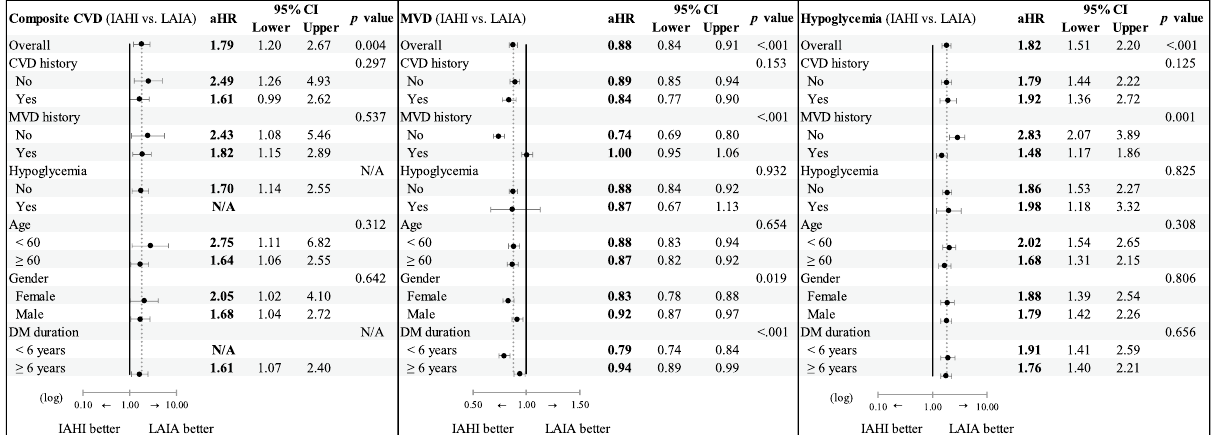
Figure 2. Primary and subgroup analyses for study outcomes of composite cardiovascular diseases, microvascular diseases, and hospitalized hypoglycemia for intermediate-acting human insulin versus long- acting insulin analogue (reference group). IAHI, intermediate-acting human insulin; LAIA, long-acting insulin analogue; aHR, adjusted hazard ratio; CVD, cardiovascular disease; MVD, microvascular disease; DM, diabetes mellitus; N/A, not available. (1) “N/A” indicates “not available”, indicating that the study event number was zero in any comparison subgroup and thus the analysis was not performed. (2) The variables adjusted in these analyses were age, gender, hospital grade, history of retinopathy, and cerebrovascular disease, which are shown to be statistically different between IAHI and LAIA users at baseline (in terms of standardized mean difference value of > 0.1) in Table